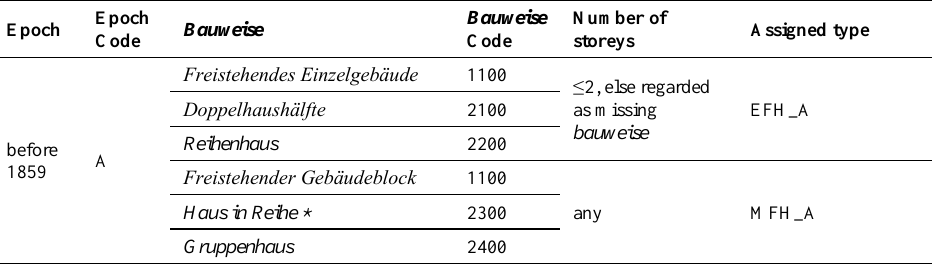
Table 6. O VERVIEW OF A SSIGNING R